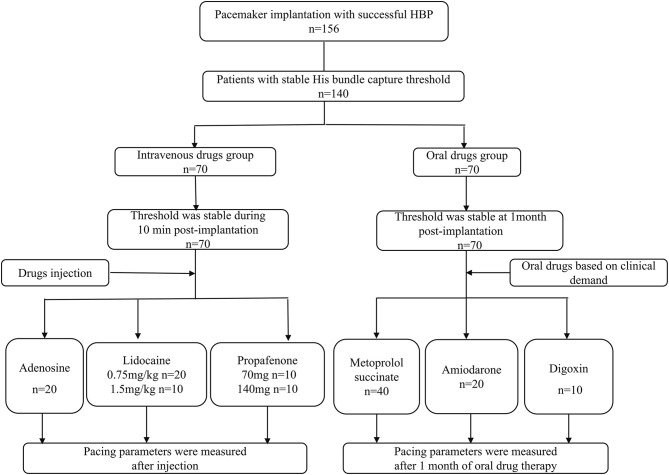
Flow chart of patients and route of administration of rhythm and rate-controlling drugs.